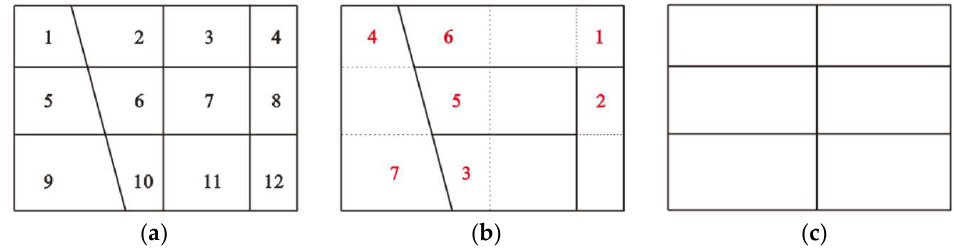
Figure 4. Schematic diagram of the limitations of the mesh-based selection method: ( a ) original road network area with aggregated small meshes; ( b ) selection result of the mesh-based method; and ( c ) desired output from a cartographer.